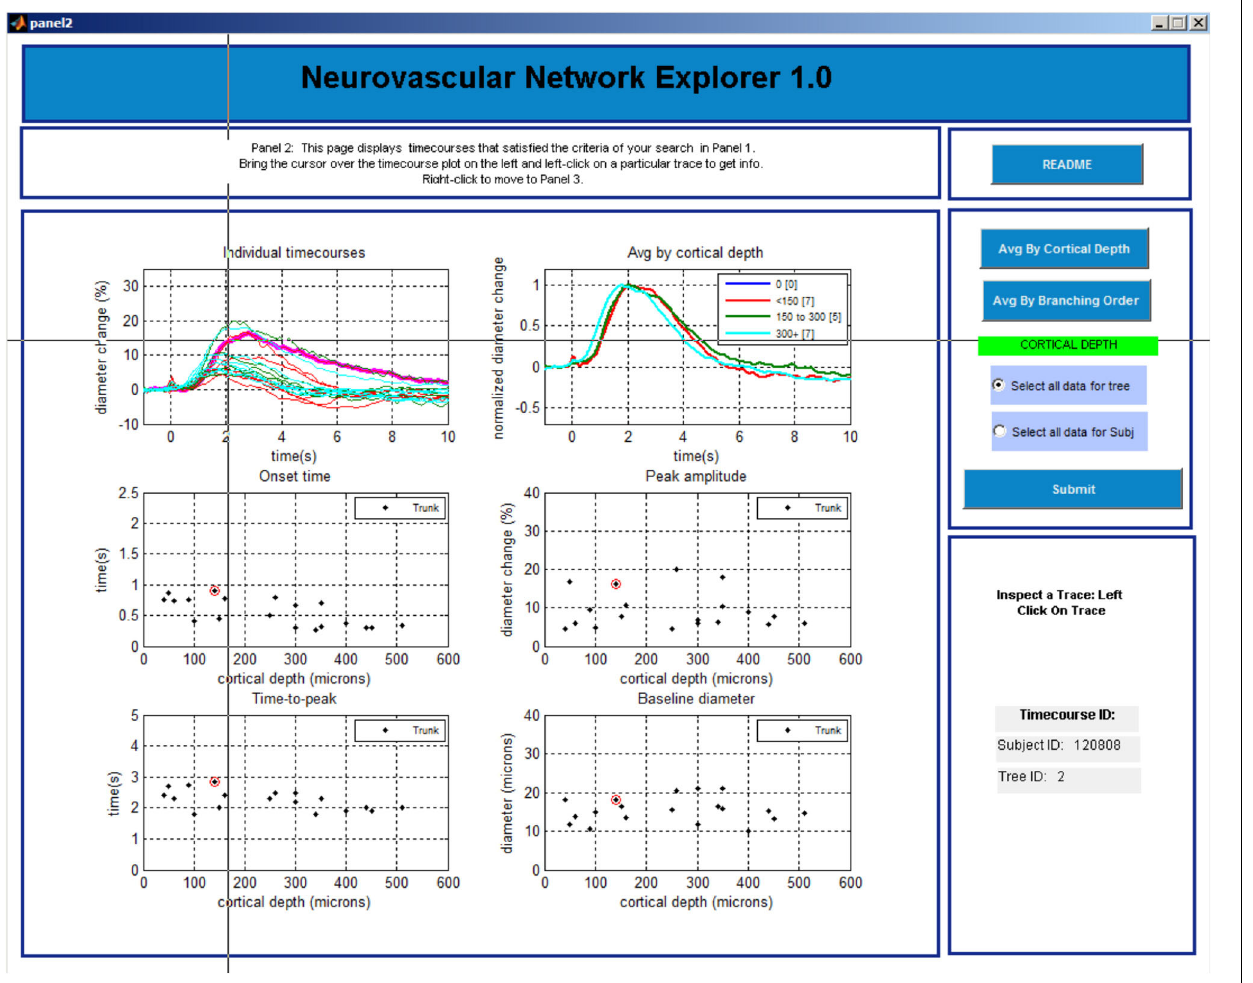
FIGURE 4 | GUI, panel